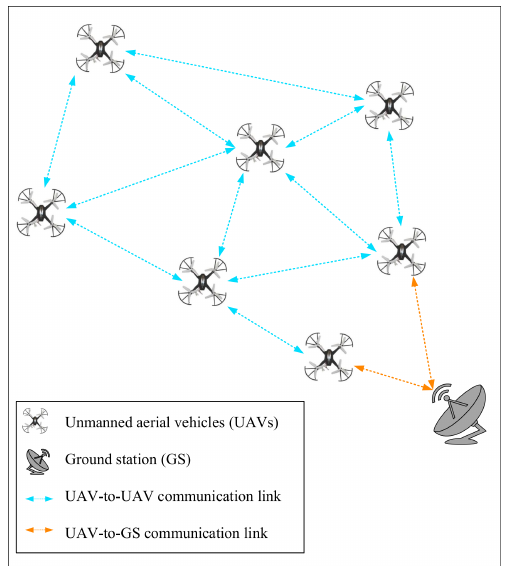
Figure 1. Flying ad hoc